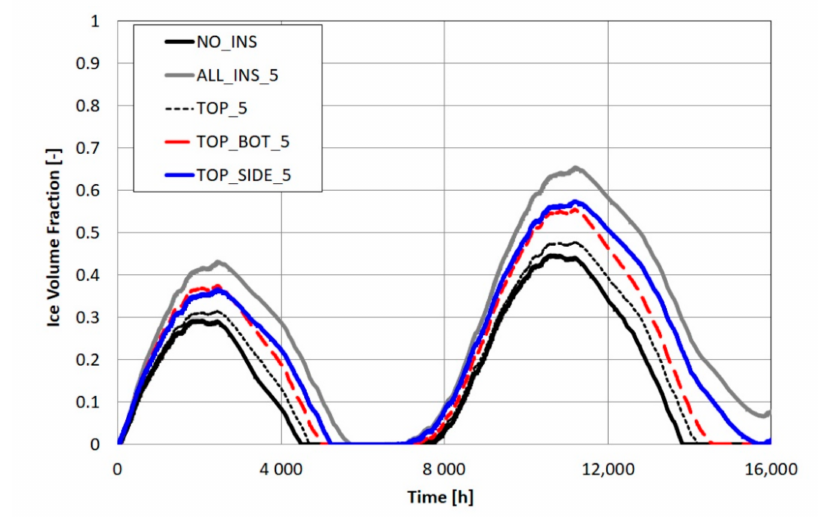
Figure 8. Ice volume fraction over the two-year simulation with cases with 5-cm thick